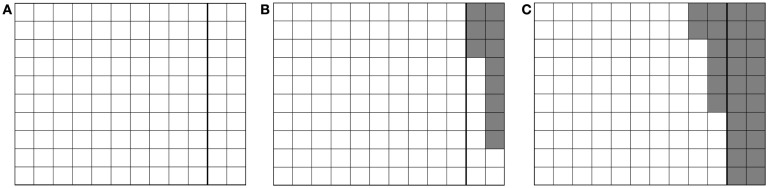
Adjusted shape of CT as time progresses. Untouched voxels are shown in white, deleted ones in gray. The two layers of voxels on the right are the extra padding. (A) time t0
(B) time ti
(C) time tj